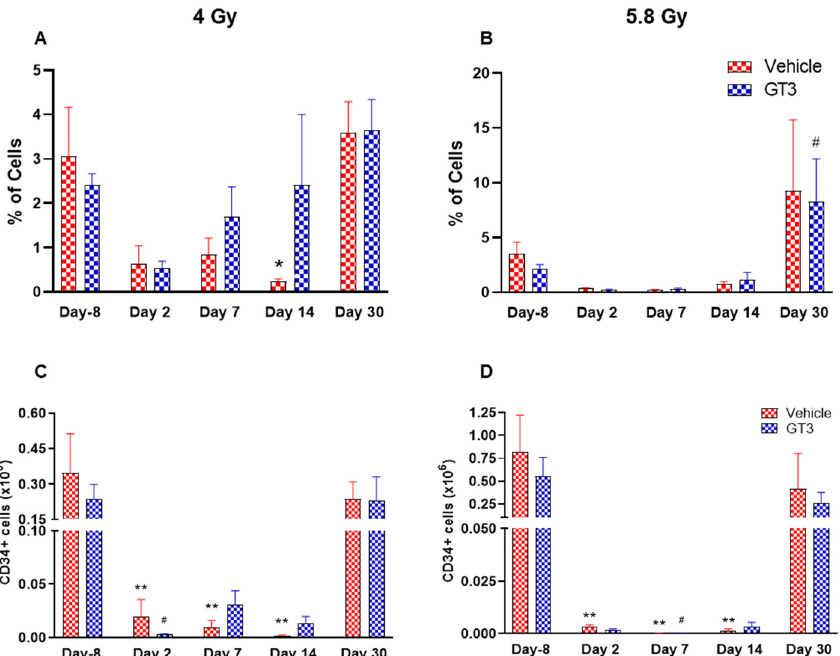
Figure 5. Effects of 4 and 5.8 Gy on CD34 percentages ( A , B ) and total cell counts ( C , D ) in BM of NHPs. NHPs received GT3 (37.5 mg/kg) or vehicle 24 h prior to irradiation (4 and 5.8 Gy). BM was collected at various time points and expression of CD34 + cells ( A , B ) and total number ( C , D ) were analyzed. Data are expressed as mean ± SEM. * p < 0.05, ** p < 0.01 vs. vehicle day-8; # p < 0.05 vs. GT3 day-8.